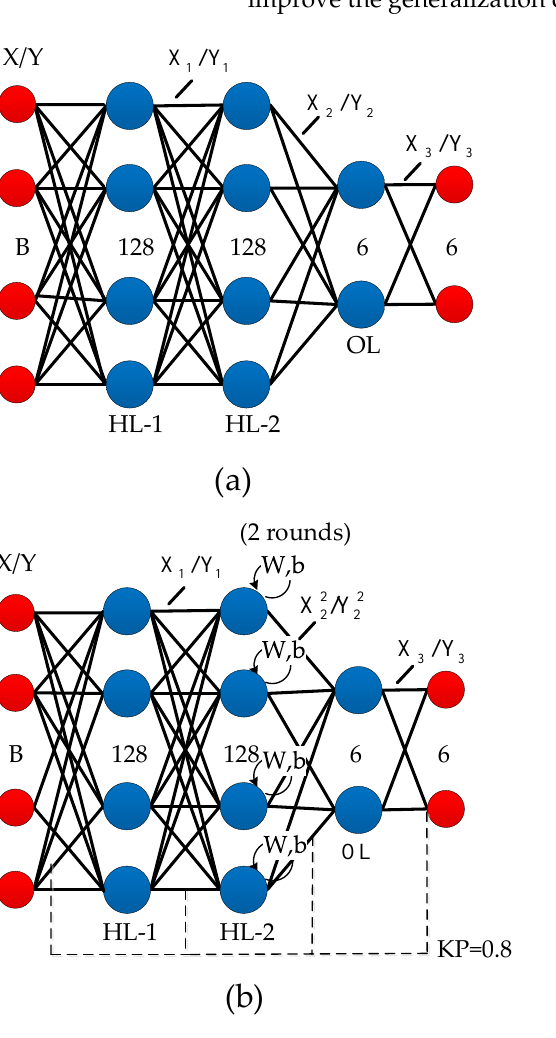
Figure 1. Flowchart of proposed CD-SDN.